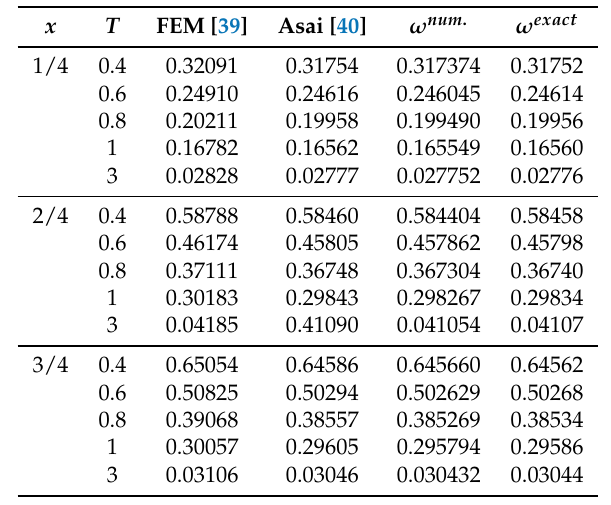
Table 5. Comparison of existing and present results for ∆ x = 0.0125, ν d = 0.2, τ = 0.0001 at different value of T for problem 5.2.